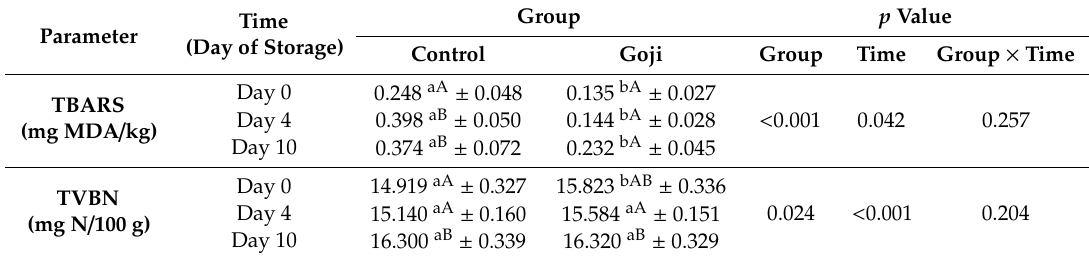
Table 2. Effects of Goji berries inclusion in the diet of rabbits on thiobarbituric reactive substances (TBARS) and Total Volatile Basic Nitrogen (TVBN) at different days of storage (mean ± standard error).